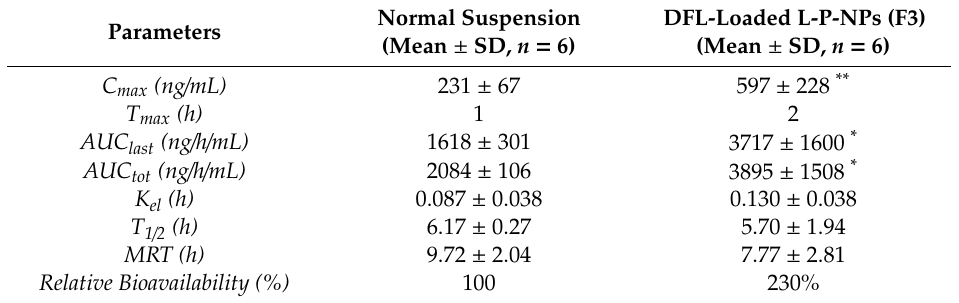
Table 4. Comparative pharmacokinetic profile of DFL-loaded L-P-NPs (F3) vs. normal suspension. Parameters